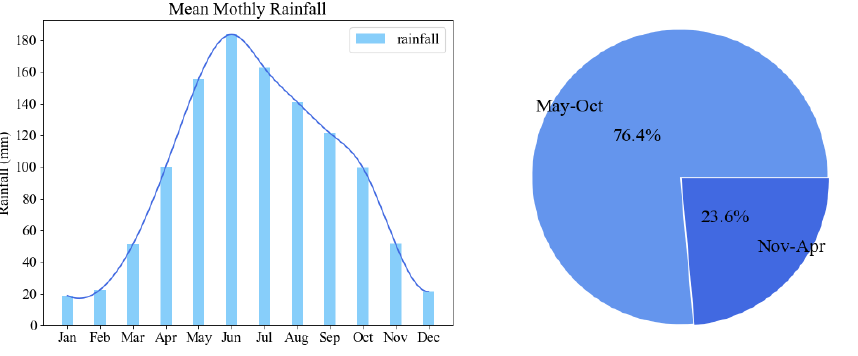
Figure 2. Monthly mean rainfall spanning from 1991 to 2019 and the difference between rainy and dry season in accumulated